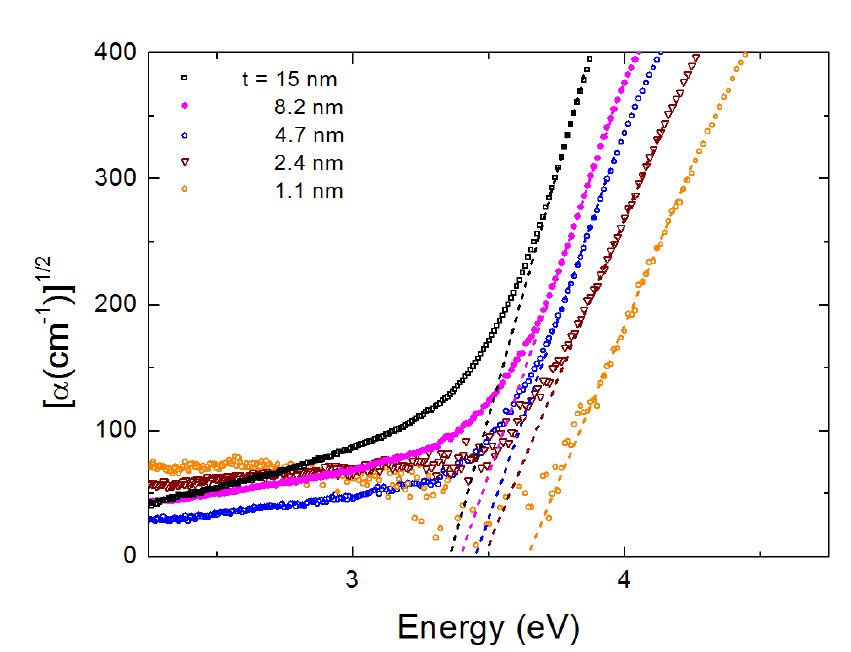
Figure 6. Tauc plots ( ( α ) 1/2 as a function of E) for five rutile films; their thickness t is indicated. A “blue” shift of Eg determined by the Tauc plots is observed.